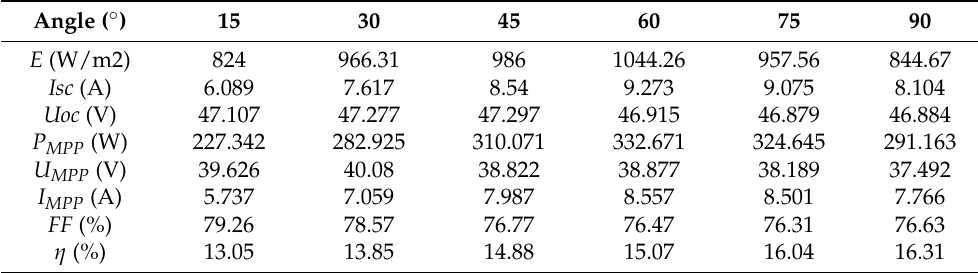
Table 4. Results of measurements and calculations for a grassy substrate.